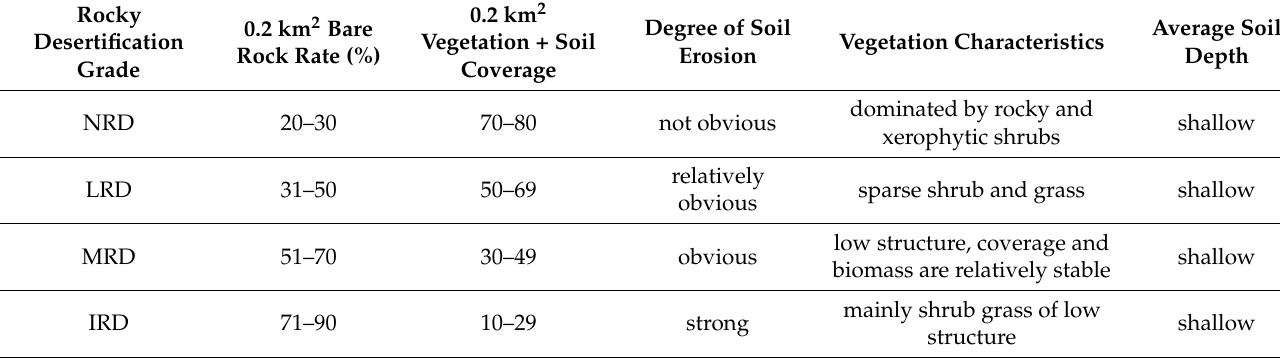
Table 1. Classification standard of different rocky desertification grades in the study: non rocky desertification (NRD), light rocky desertification (LRD), moderate rocky desertification (MRD) and intense rocky desertification (IRD).